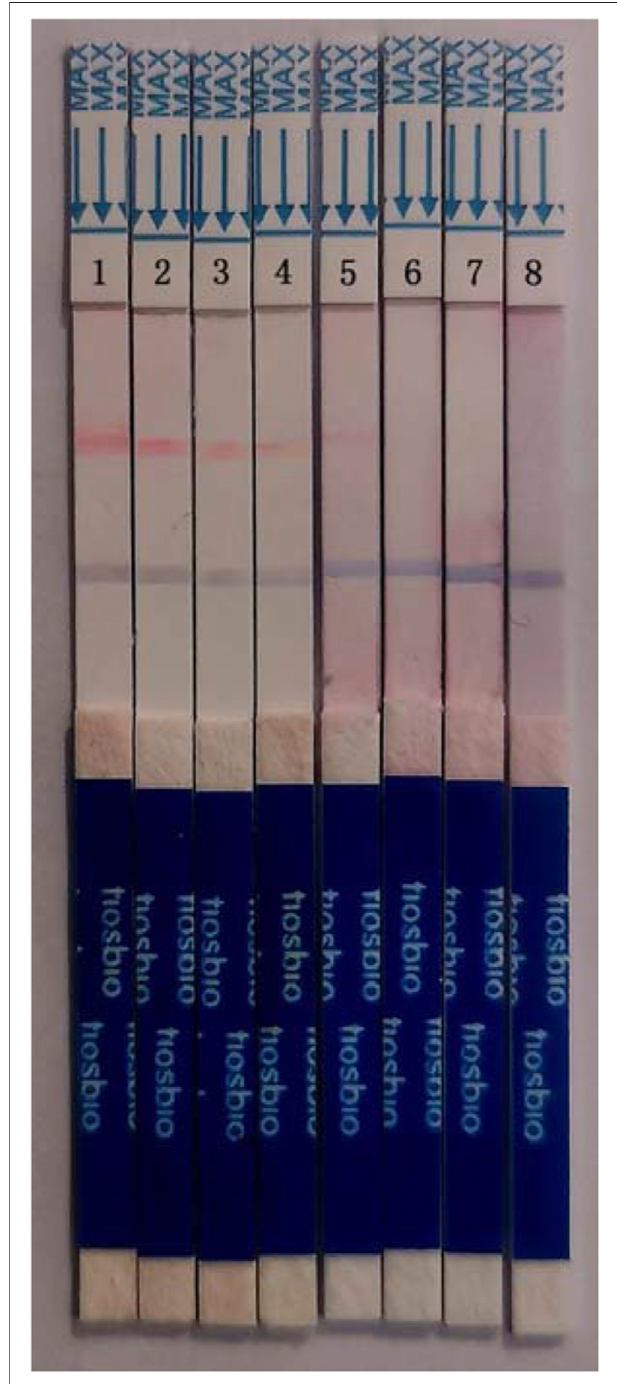
FIGURE 5 | The products of a serial dilution of HBV plasmid DNA measured in MIRA-LFD. 1, product of 1 ng template; 2, product of 100 pg template; 3, product of 10 pg template; 4, product of 1 pg template; 5, product of 100 fg template; 6, product of 10 fg template; 7, product of human genome template; 8, product of water